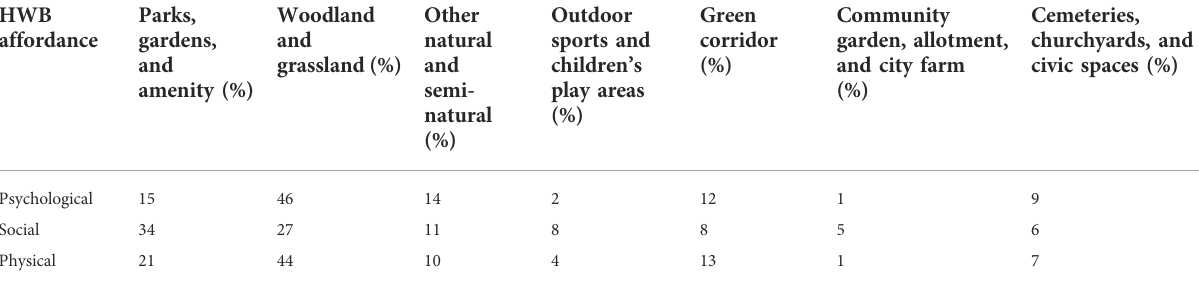
TABLE 5 Human wellbeing affordances and urban greenspace typologies. Individual UGS affordances (n = 385) provided by respondents. HWB